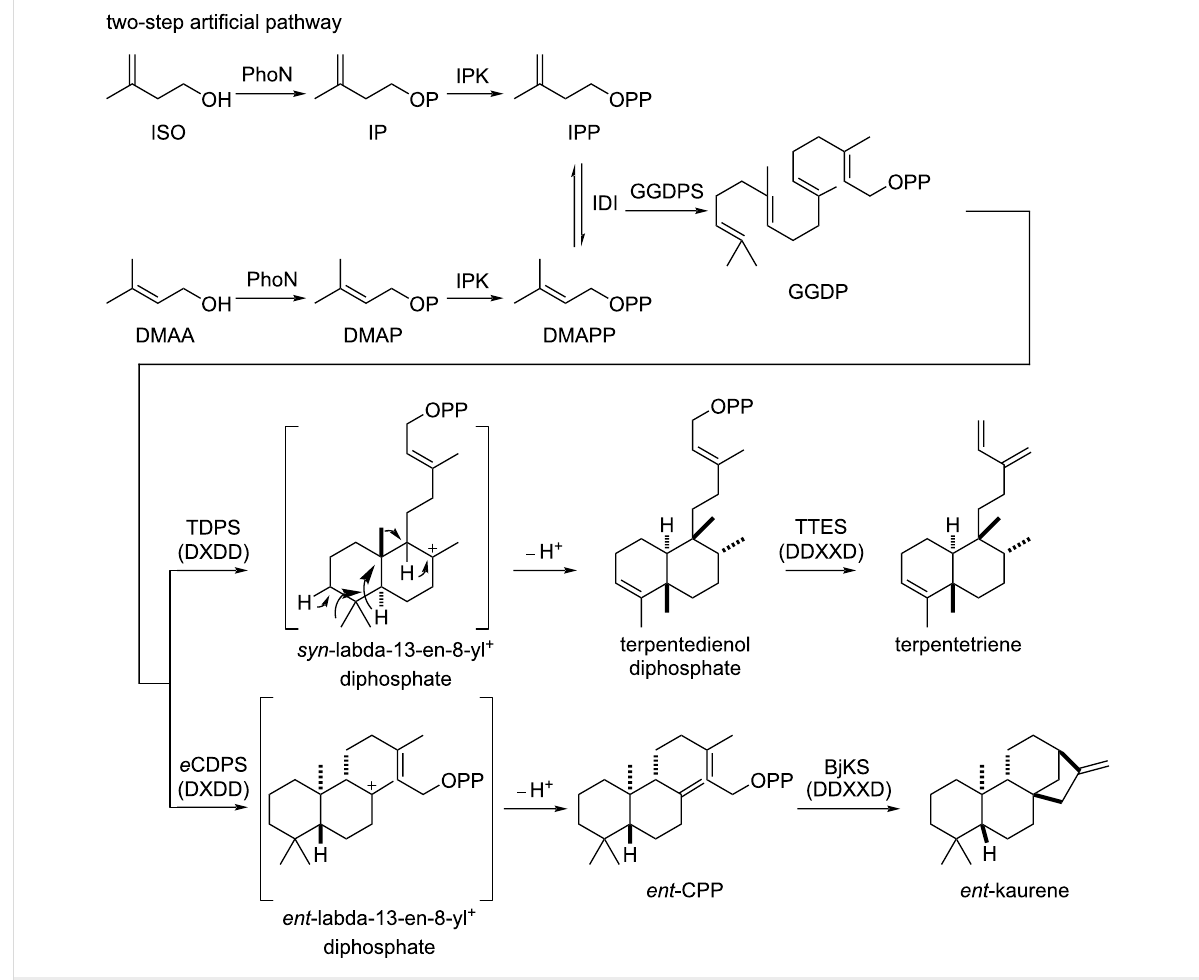
Figure 2: Truncated artificial pathways (six steps) to produce terpentetriene and ent -kaurene.